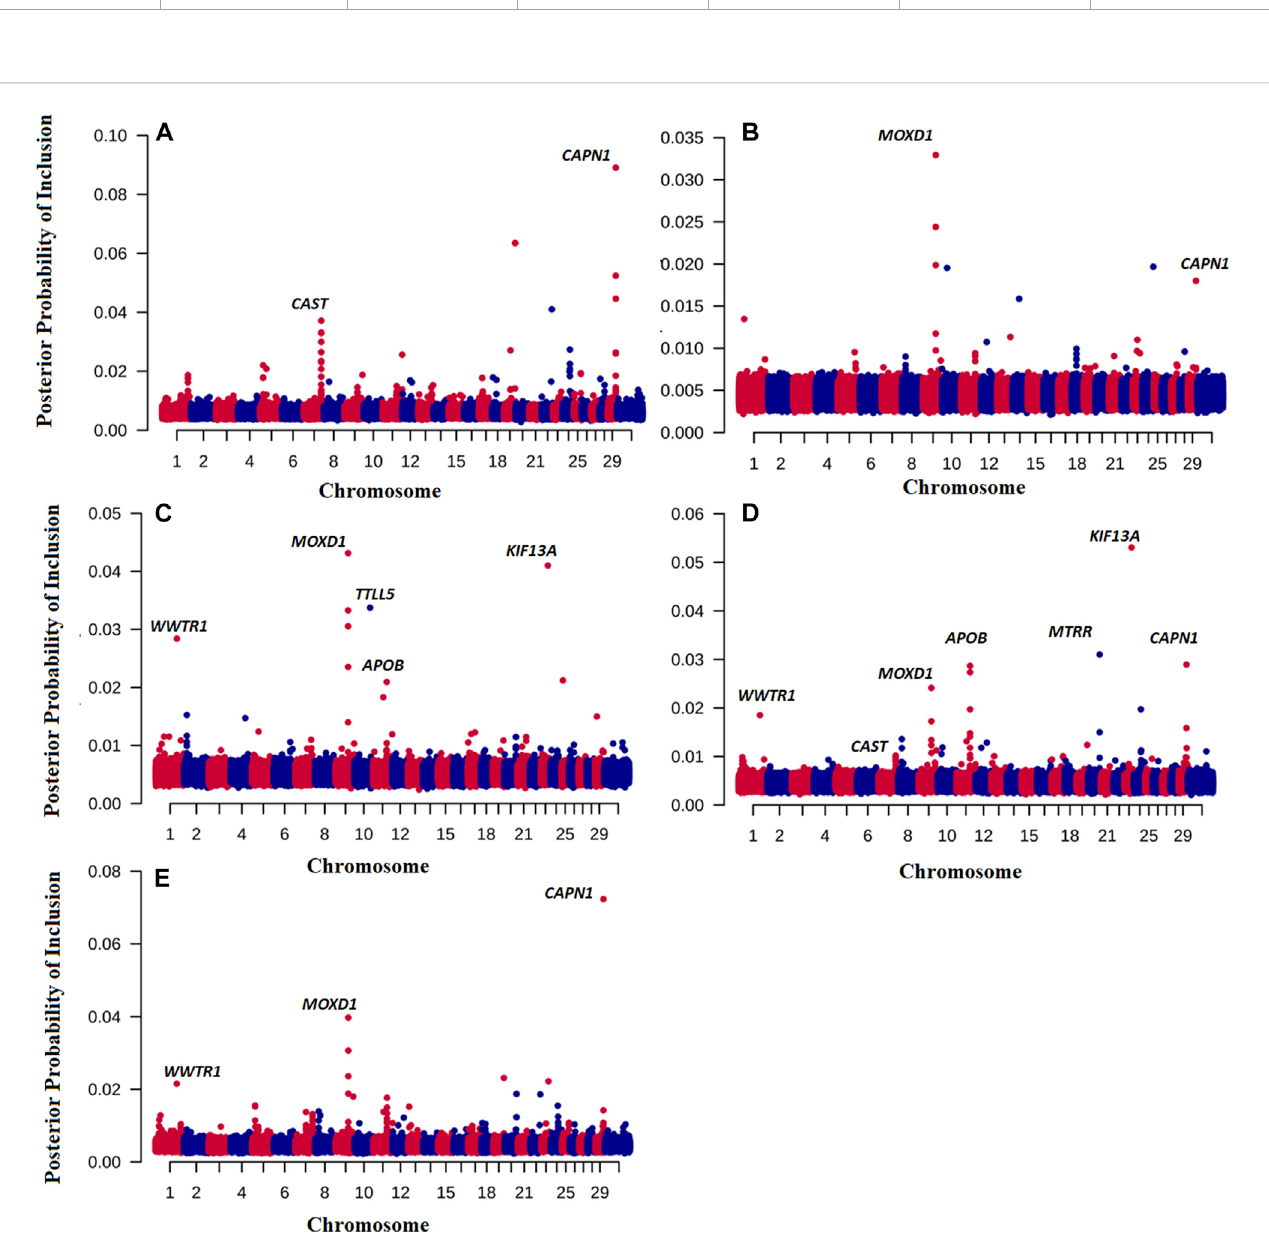
FIGURE 1 PosteriorprobabilityofinclusionintheBayesRpredictionmodelfor7,09,698SNPforTENDER (A) ,Juicy (B) ,Flavour (C) ,OVERALL (D) ,andMQ4 (E) traits. Odd chromosomes are colored in red, even chromosomes are colored in